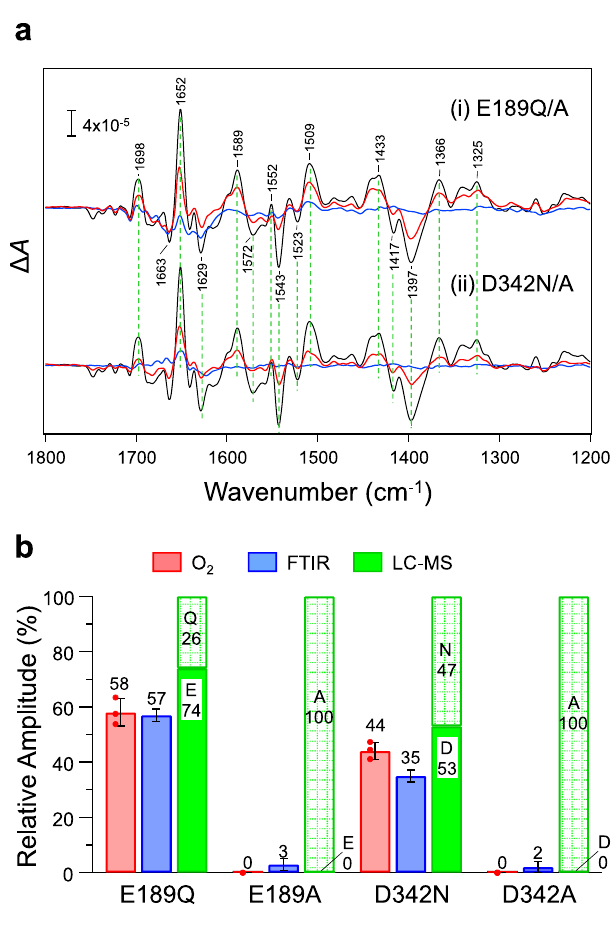
Fig. 3 FTIR and LC-MS analyses of the D1-E189Q/A and D1-D342N/A mutants. a S 2 /S 1 FTIR difference spectra of the PSII complexes from (i) D1- E189Q (red line) and E189A (blue line) and (ii) D1-D342N (red line) and D342A (blue line) cells in comparison with the spectrum of WT* PSII (black lines). The amplitudes of the spectra were normalized based on the protein amounts estimated from the amide II band. b Comparison of the O 2 evolution activity (red bars) and the FTIR amplitude ( Δ A between 1433 and 1397 cm − 1 ; blue bars) relative to those of WT* and the relative contents of amino acid residues at the mutation sites estimated by LC-MS analysis (green bars) in the PSII complexes from D1-E189Q, E189A, D342N, and D342A cells. The O 2 evolution activities were presented as mean values ± standard deviation ( n = 3), and the error of the FTIR amplitude was estimated from the root-mean-square noise level in the 1400 – 1390 cm − 1 region of the dark-minus-dark spectrum. Source data are provided as a Source Data fi le.